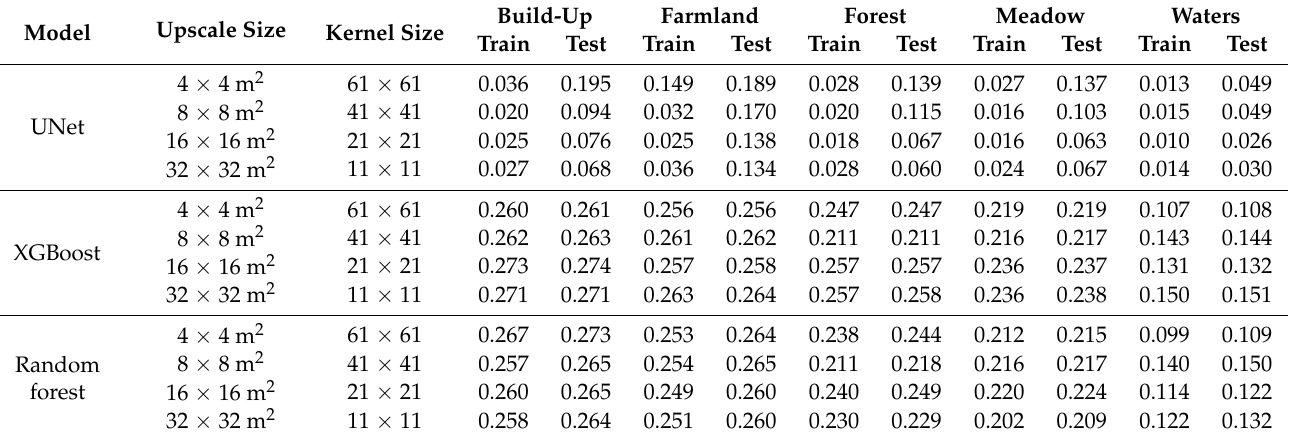
Table 2. Performance (RMSE) of local surface complexity UNet models with varying upscales and kernel